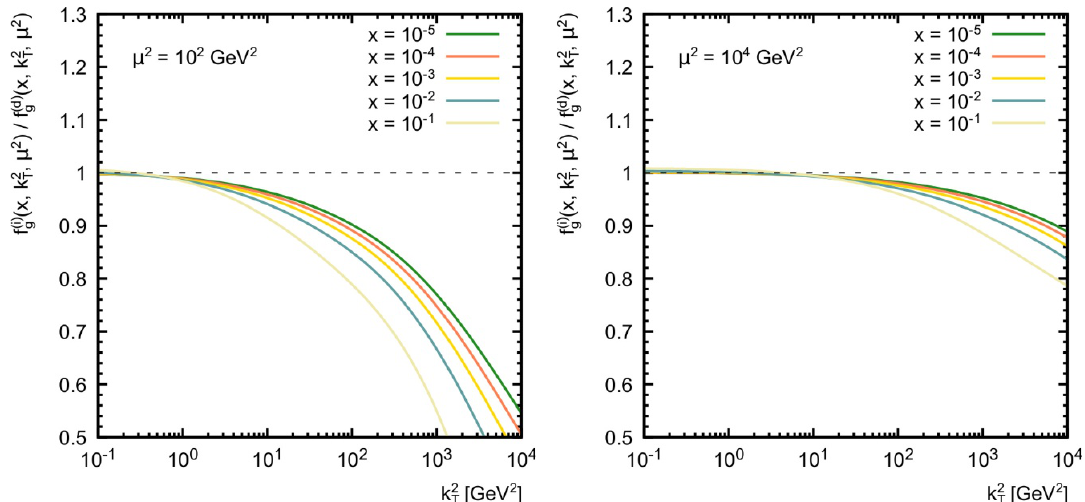
at di(cid:11)erent T